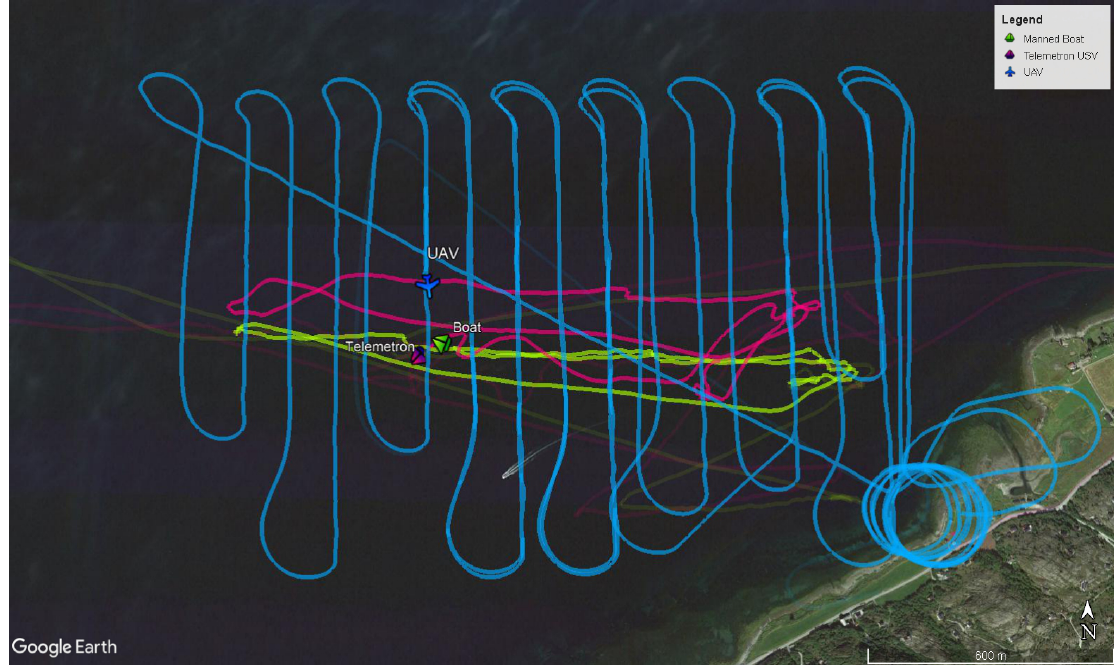
Figure 16. A partial GNSS track of the UAV’s and the two surface vehicles’